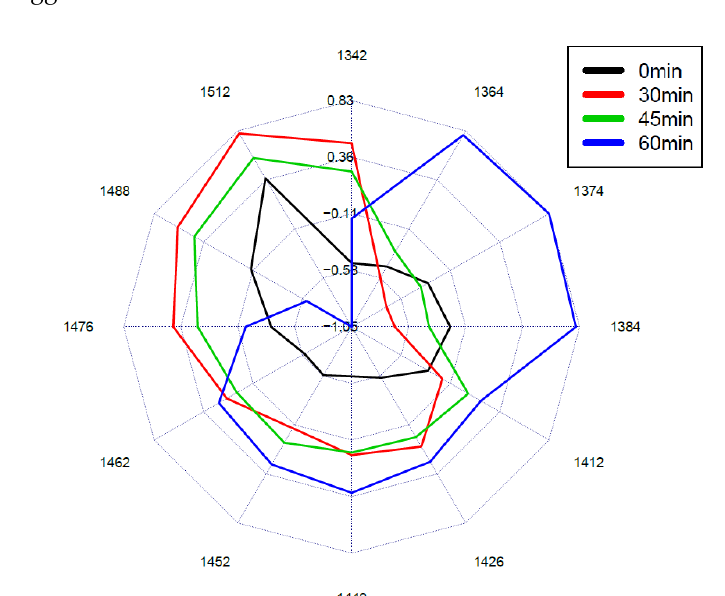
Table 3. The accuracy of the observed models. Group Treatment Recognition